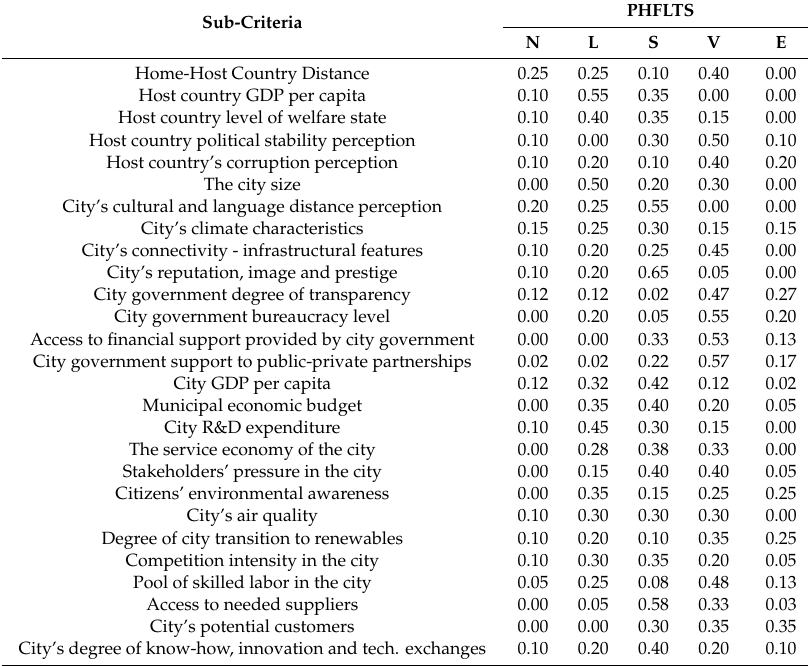
Table 5. Each row denotes the five-dimensional proportional vector corresponding to the EHFLTSs of each sub-criterion. Table 5. PHFLTSs of the aggregated linguistic information for each sub-criterion.